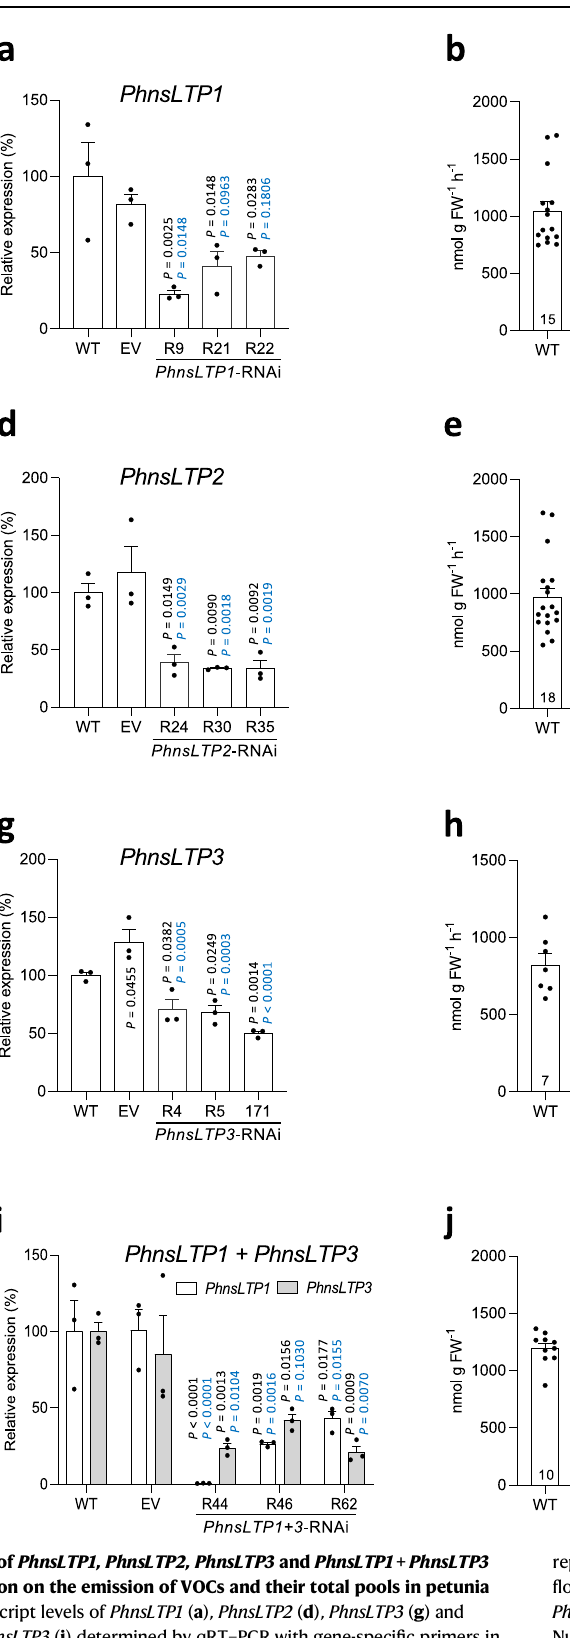
replicates). Total VOC emission ( b , e , and h ) and total pools ( c , f , j ) in 2-day-old fl owersfromWT,EV,andRNAilines: PhnsLTP1 ( b,c ), PhnsLTP2 ( e,f ), PhnsLTP3 and PhnsLTP1 + PhnsLTP3 ( h and j ). All emission and total pool data are means±S.E. Numbers at the bottoms of the columns in b , c , e , f , h , and j show the numbers of biological replicates. All P -values were determined by one-way ANOVA with Dun- nett ’ s multiple comparisons test relative to the WT (black) and EV (blue) controls except for i , for which P -values were obtained by two-way ANOVA with Tukey ’ s multiple comparisons test. FW, fresh